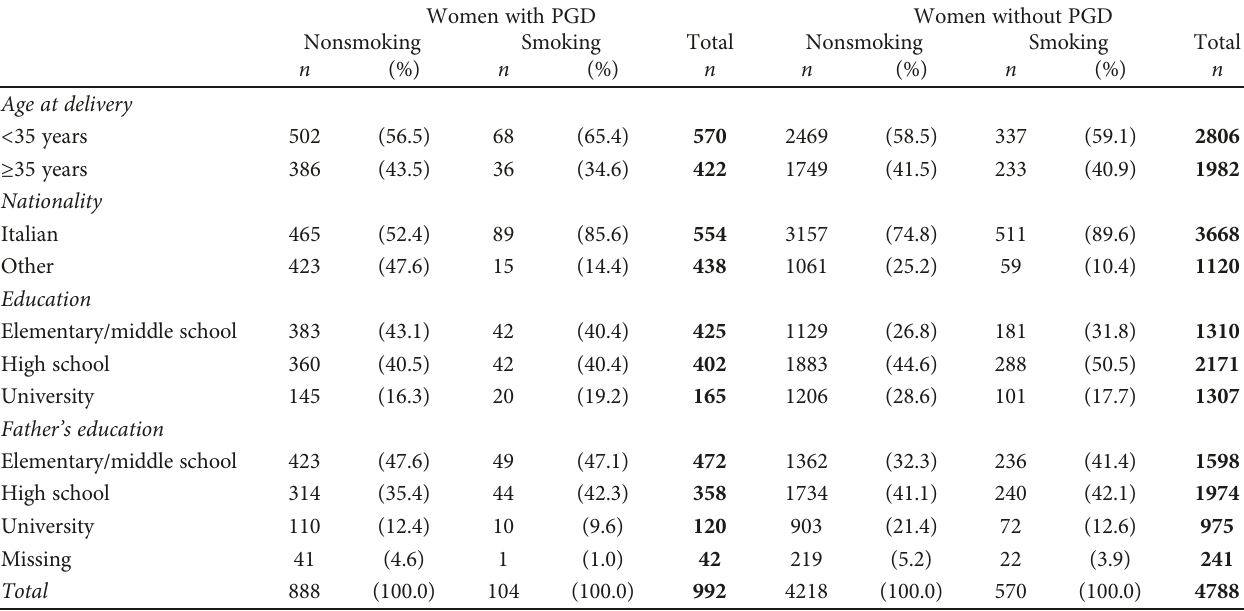
Table 1: Demographic characteristics of the study population, according to maternal pregestational diabetes and smoking habits.